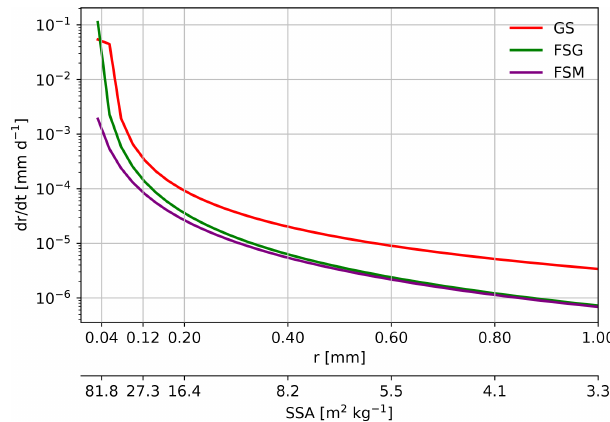
Figure 1. Dry snow grain growth as a function of grain radius ( r ) and specific surface area (SSA) for the Rp3 experiments GS, FSG and